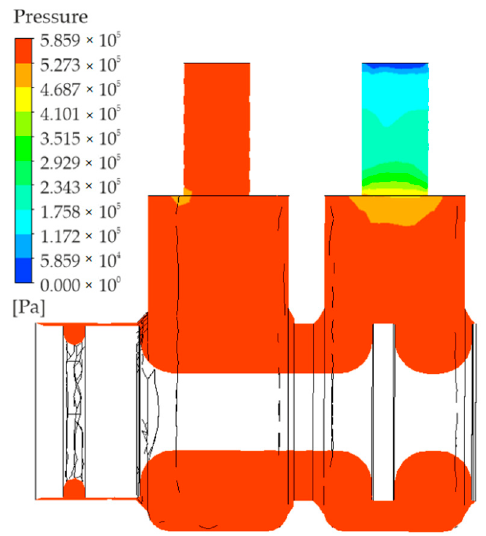
Figure 6. Distribution of pressure.